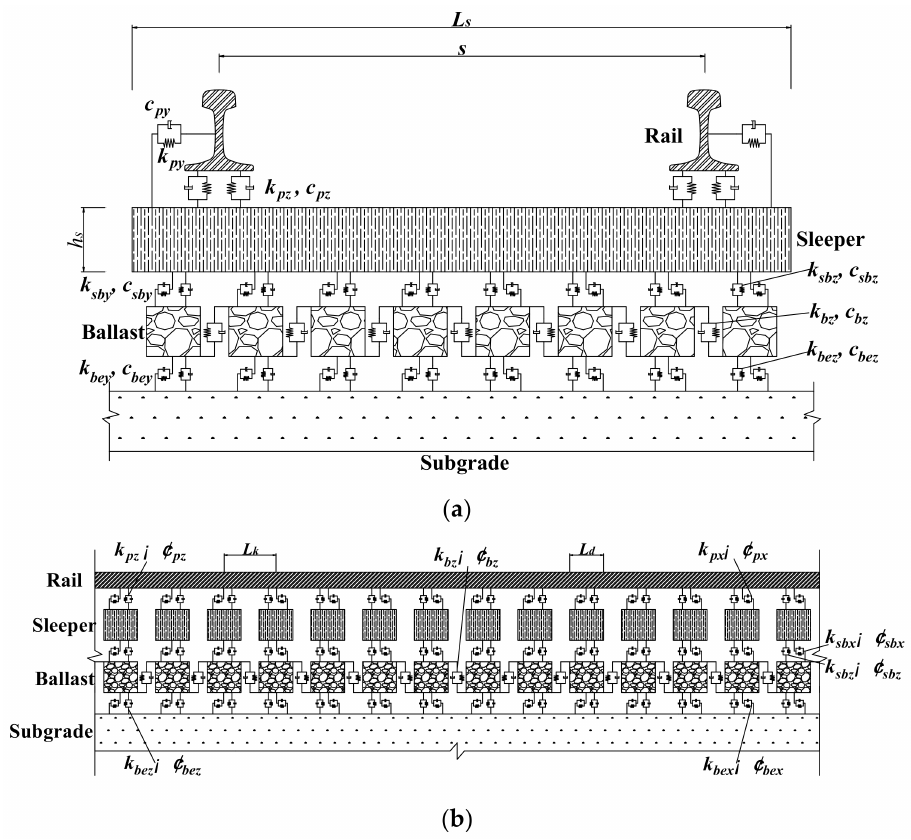
Figure 3. Illustration of the ballasted track model developed: ( a ) transverse section view and ( b ) longitudinal section